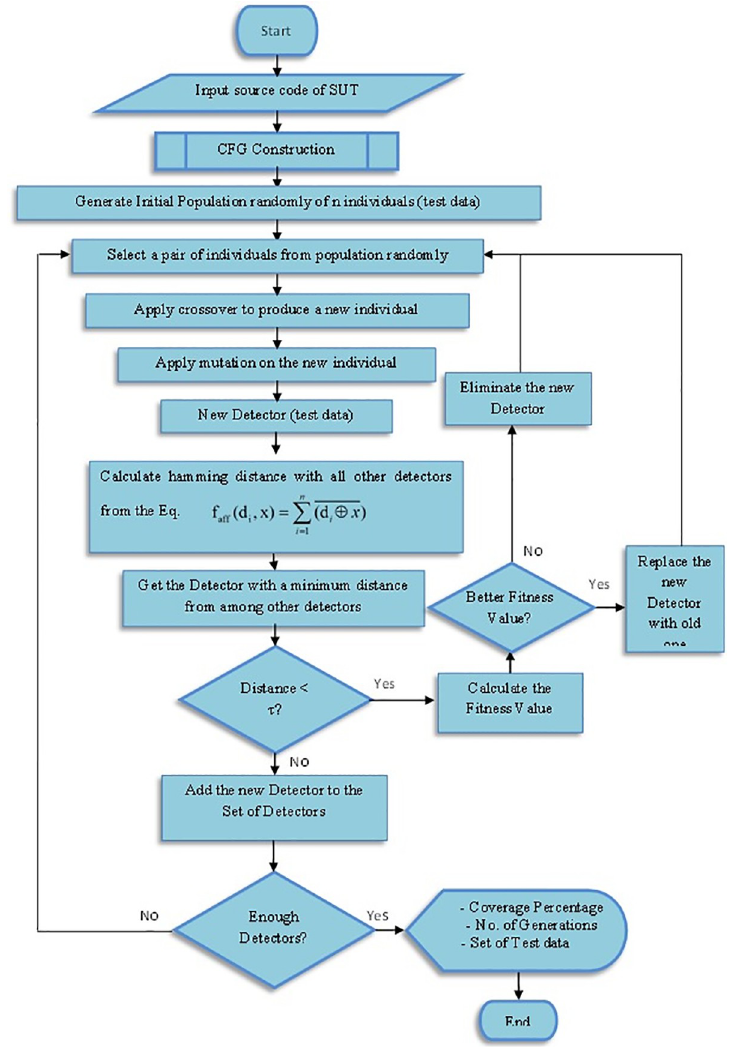
Fig 3. The flowchart of the proposed NSA-GA